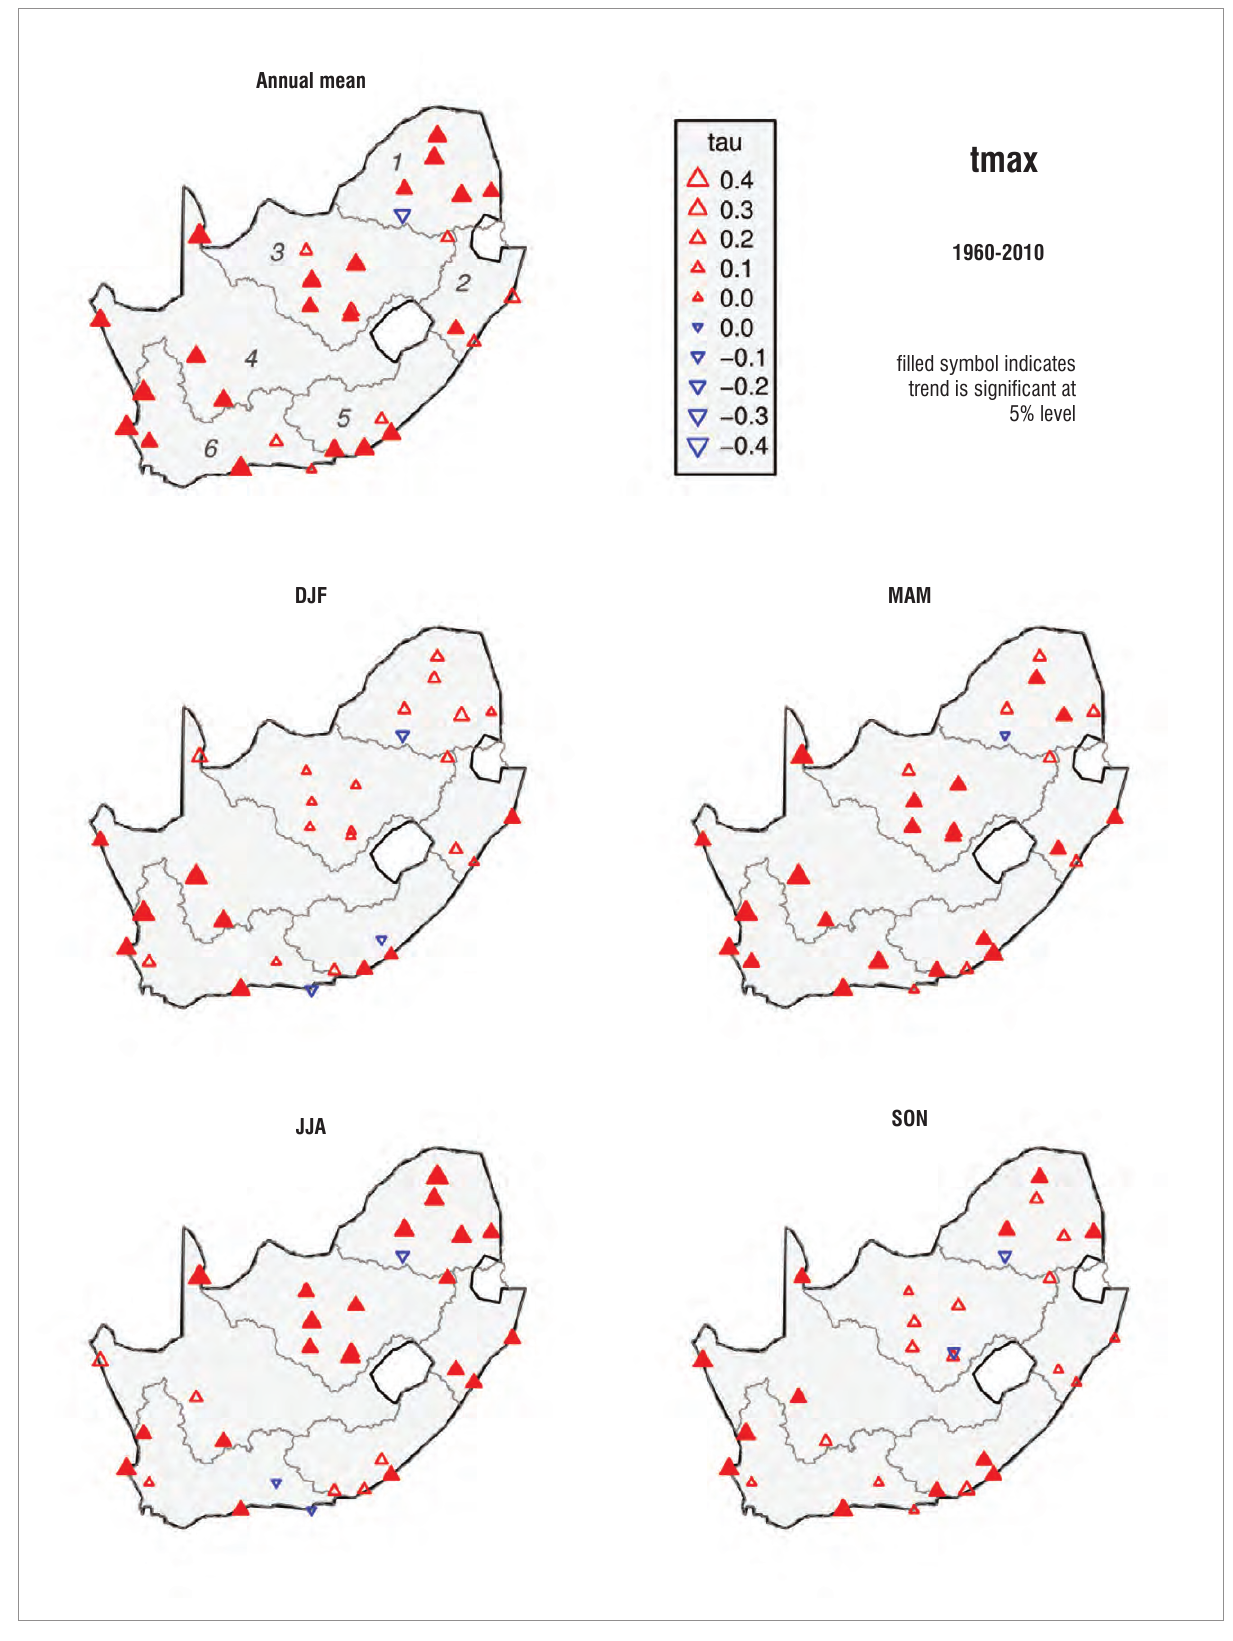
Figure 3: Trends in annual and seasonal mean daily maximum temperature (tmax, °C) for each station according to the Mann–Kendall test. The value of tau represents the direction and relative strength of the trend. Shaded symbols denote trends that are significant at the 5% level. Seasons are summer (DJF), autumn (MAM), winter (JJA) and spring (SON). Grey borders represent boundaries of the six water management regions, which are identified by number (1–6) in the annual mean